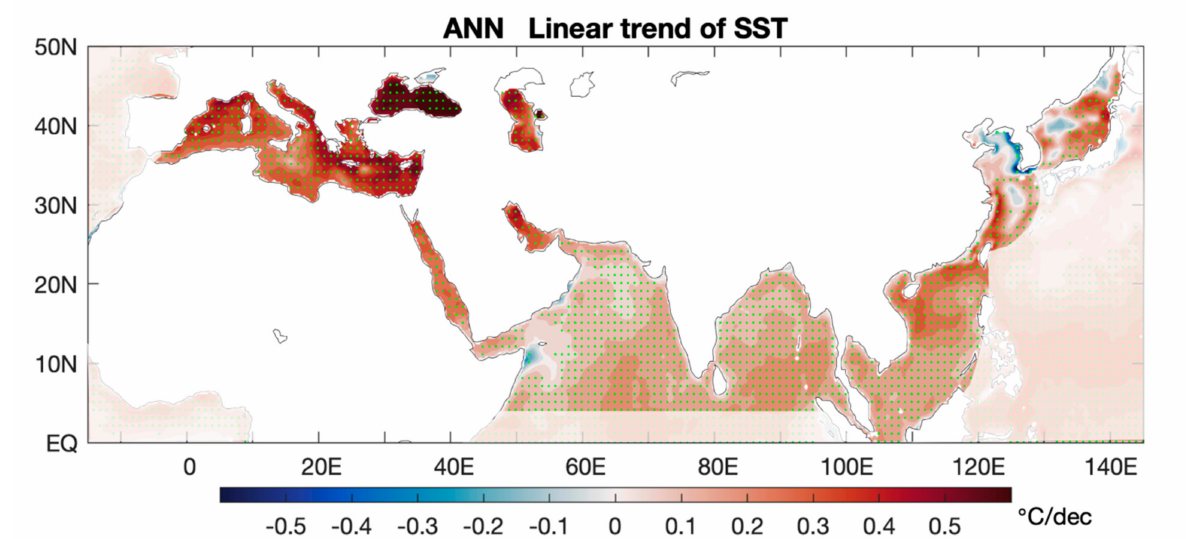
Figure 12. Linear trends of annual mean SST for 1988–2018. The green dotted areas denote the linear trends of wind speed that are significant at the 90% confidence interval. The ocean regions outside of the marginal seas are